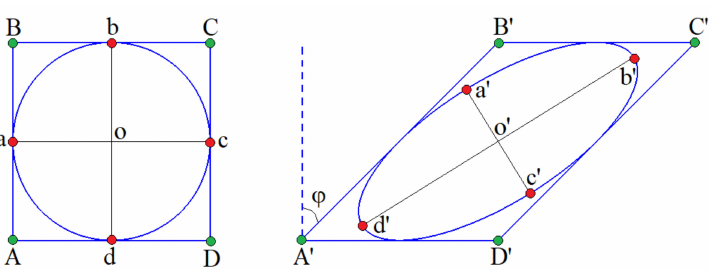
Figure 22. Schematic illustration of simple shear during ECAP.